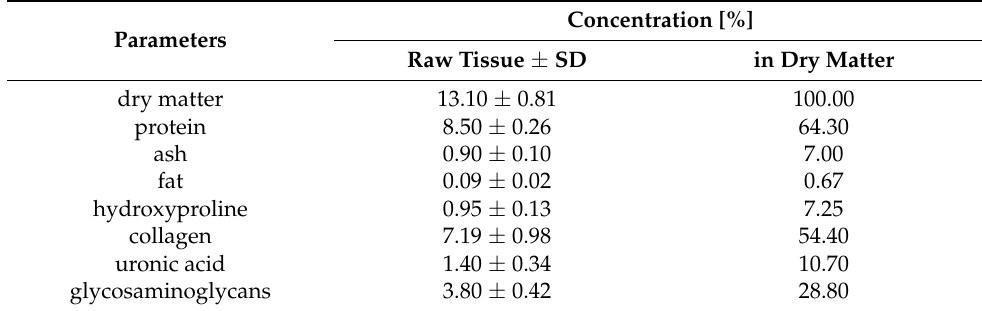
Table 1. The chemical composition of the chicken keel cartilage.